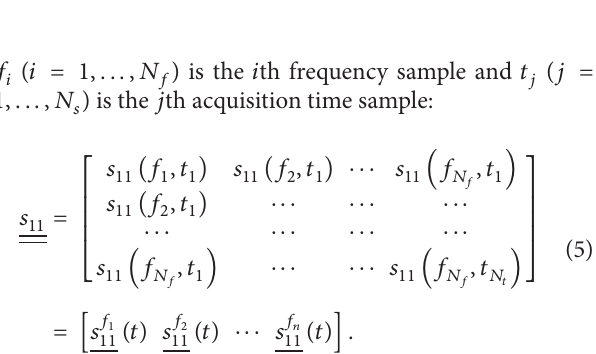
Figure 6: Measured breathing frequency.